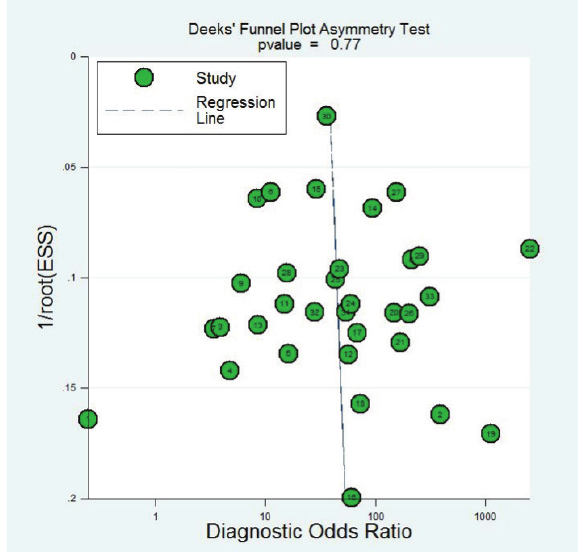
Figure 10: The funnel plot of publication bias for 1,3-β-D-glucan in diagnosis of invasive fungal infection Table 2: The subgroup analysis of 1,3-β-D-glucan for invasive fungal infection